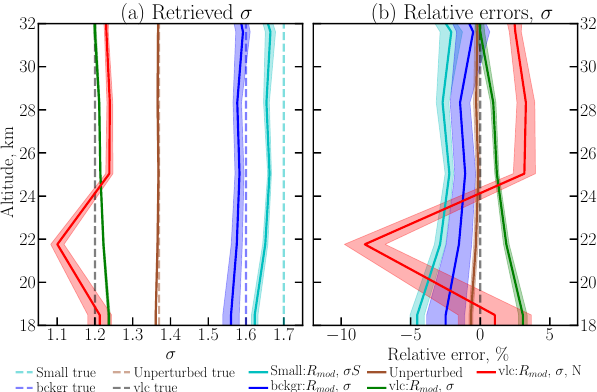
Figure 5. σ profiles (a) and their relative errors (b) for a typical tropical observation geometry. The solid lines show the retrieval re- sults, while the dashed lines represent the true values. The shaded areas stand for ± 1 standard deviation. The scenarios used for the simulations are listed in Table